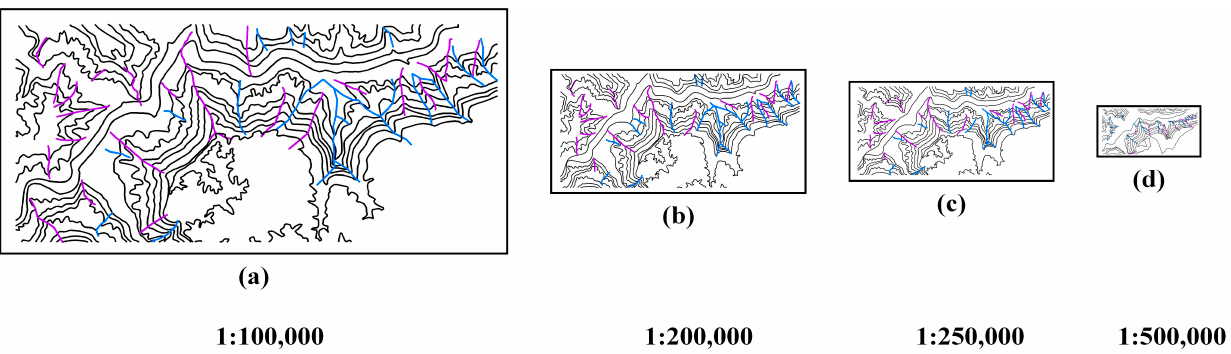
Figure 20. ( a – d ) Topographical feature retention of the terrain map at the 1:100,000, 1:200,000, 1:250,000, and 1:500,000 scales.